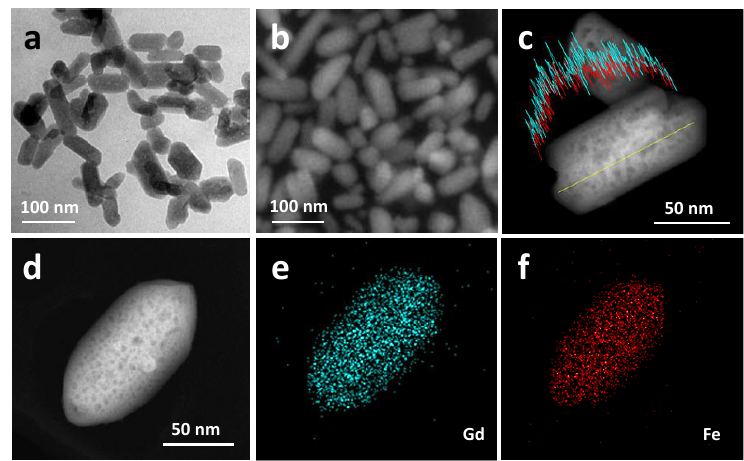
Figure 2. Electron microscopy study of as synthesized GdFe nanorods. ( a , b ): Transmission electron microscopy (TEM) ( a ) and field-emission scanning electronic microscopy (FESEM) ( b ) images. ( c ) Scanning transmission electron microscopy (STEM) image with energy-dispersive X-ray spectroscopy analysis (EDS) line scans. Legend: blue line = Gd; red line = Fe; ( d , f ): STEM image ( d ) and EDS mapping pictures of one GdFe nanorod ( e , f